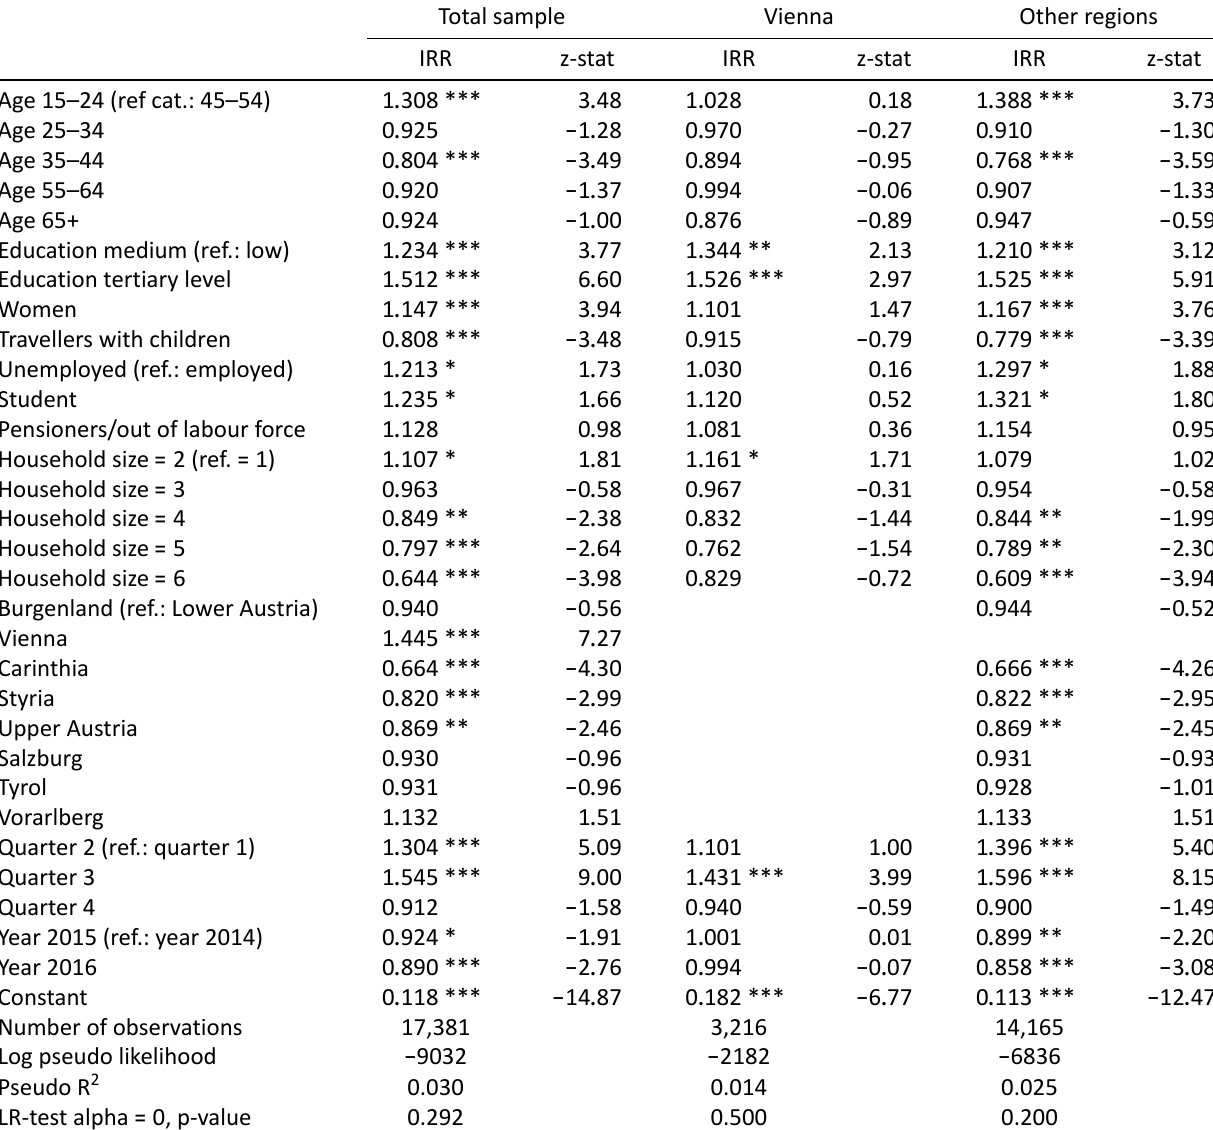
Table 4. Determinants of holiday flights 2014–2016, Poisson